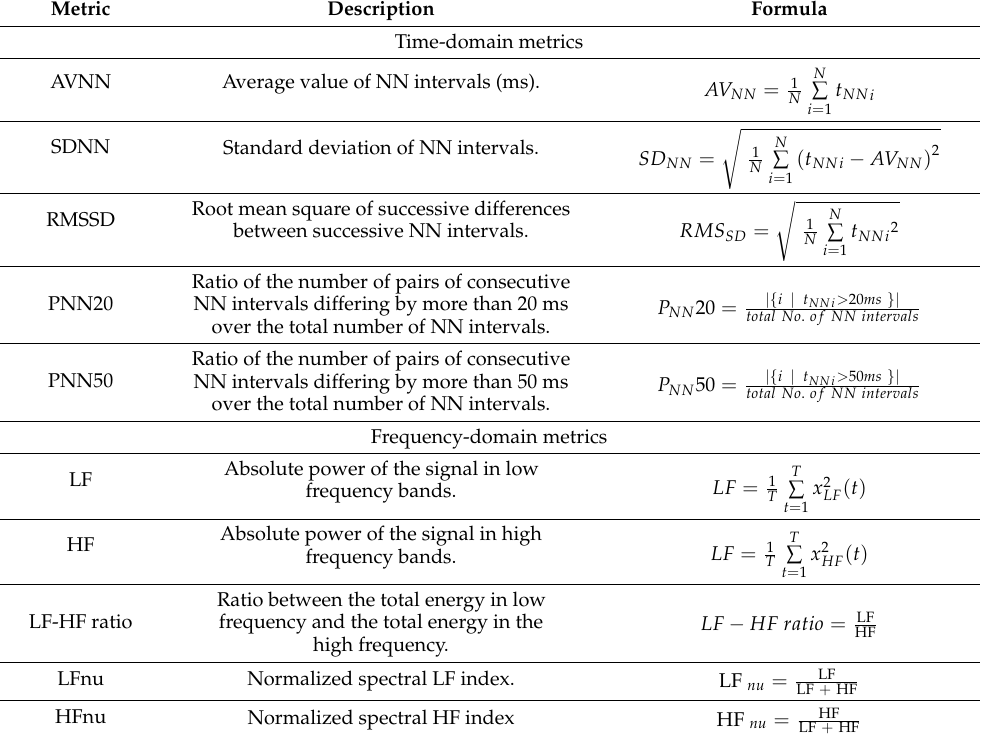
Table 1. Metrics of stress derived from ECG and HRV. Where t NNi denotes the time intervals between two consecutive R peaks, x LF is the filtered version of the HRV signal in the frequency band [0.05–0.15] Hz, T is the period of the signal and x HF is the filtered version of the HRV signal in the frequency band [0.16–0.50]